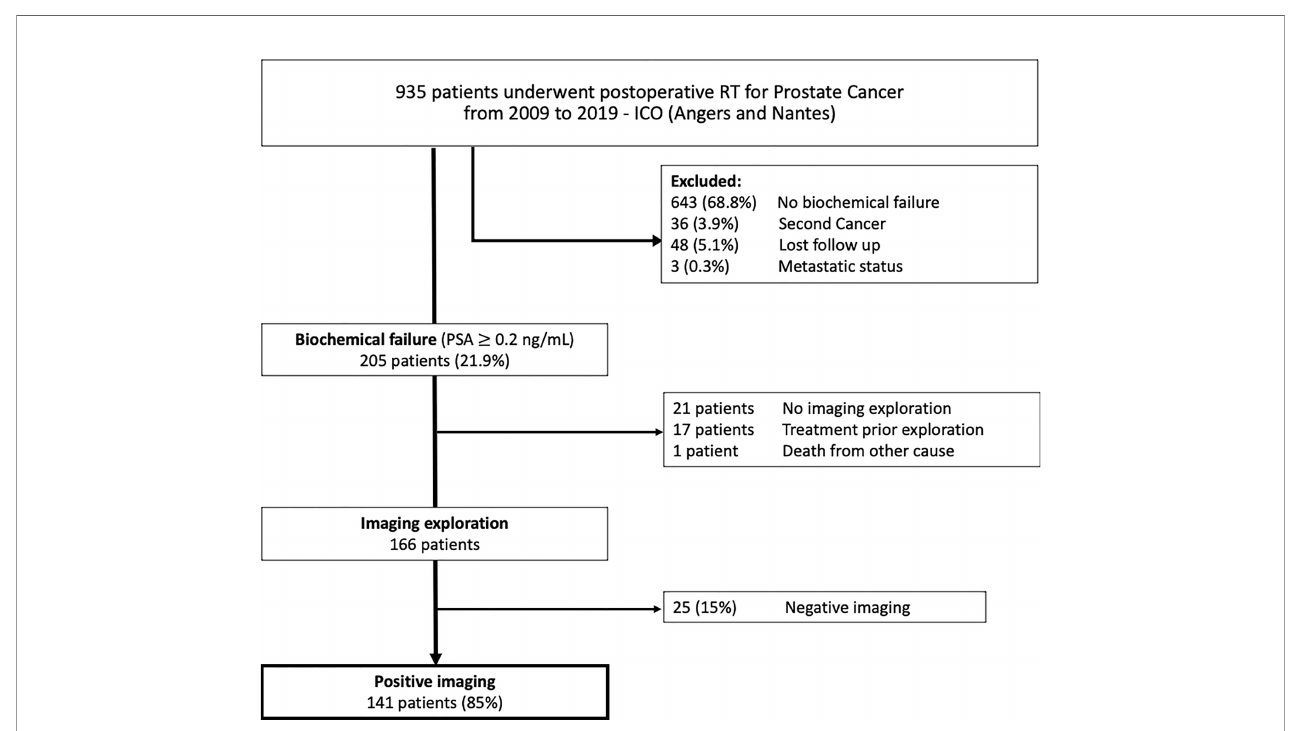
FIGURE 1 | Flow chart of study population. ICO, “ Institut de Cancérologie de l ’ Ouest ” ; RP, Radical Prostatectomy; RT,